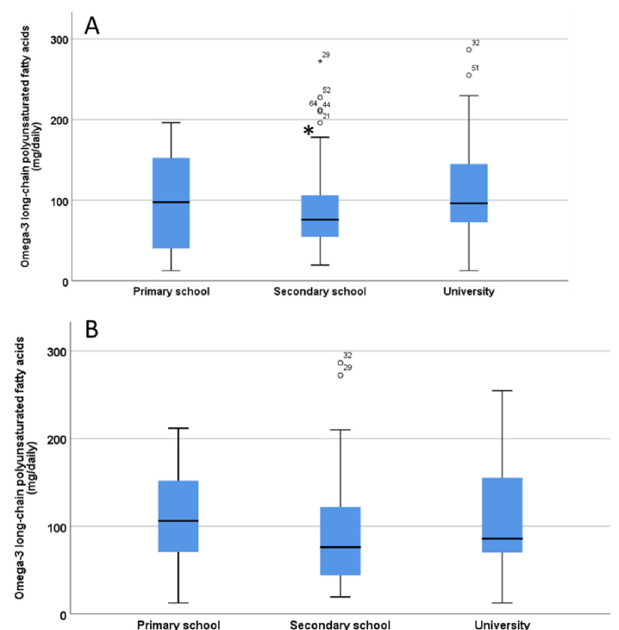
Figure 4. Estimation of omega-3 long chain polyunsaturated fatty acids (LC-PUFA) intake from fish / seafood in children / adolescents based on the level of education of the mothers ( A ) and fathers ( B ). The significant di ff erence in Panel A is indicated by the asterisk * p < 0.05. ◦ indicate outliers defined as a data points located outside the whiskers of the box plot.